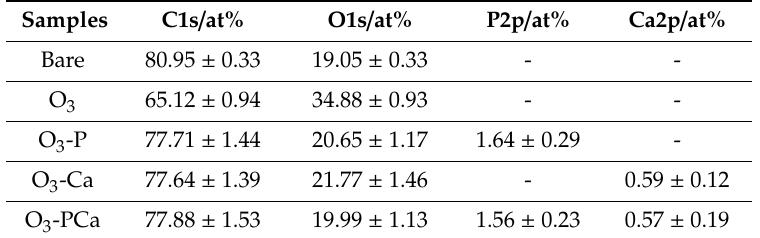
Table 1. Chemical composition of PEEK surfaces determined by XPS analysis.